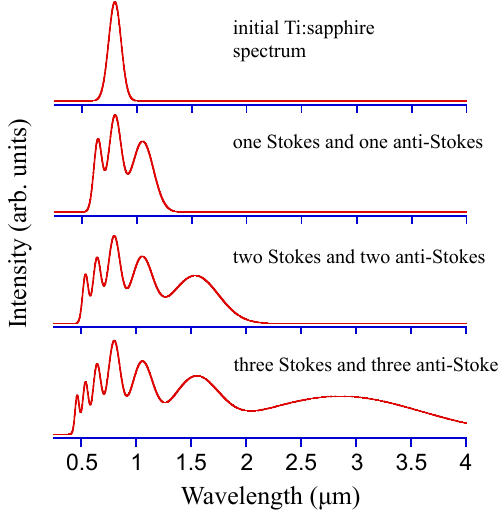
Figure 6. Broadening the spectrum of a Ti:sapphire laser using the vibrational transition in = 90 THz. Starting with a typical broadband laser with power spectral density, D with ν 2 M F ( ν ) , replicas of the spectrum spaced by the Raman transition frequency are produced. Here we follow the process up to three Stokes and anti-Stokes sidebands, i.e. , the final spectrum ) , F ( ν − 2 ν ) , ..., F ( ν + 3 ν ) . In this includes contributions from F ( ν − 3 ν M M M